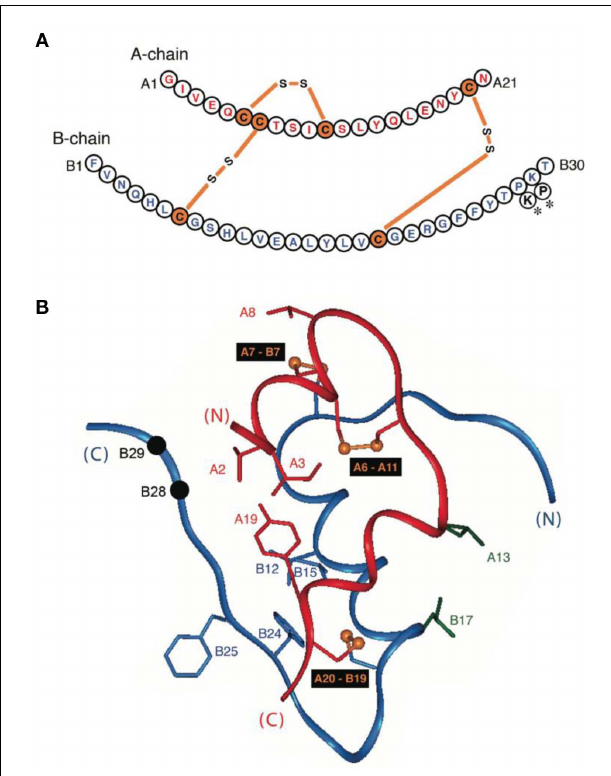
FIGURE 1 | Sequence and structure of insulin. (A) Sequence of human insulin with A-chain at top (red) and B-chain beneath (blue). Cysteines are highlighted in orange with linkages as indicated (bars). Sites of substitution in KP-insulin are indicated (asterisks). (B) Ribbon model of insulin (T-state protomer; Protein Databank accession code 4INS; Baker et al., 1988).The A-chain is shown in red, and the B-chain in blue. Disulfide bridges are indicated by gold spheres (sulfur atoms); pairings are shown in black boxes. Black spheres indicate C α carbons of residues B28 and B29 (site of sequence interchange in KP-insulin). Selected side chains at the receptor-binding surface are also shown as labeled.